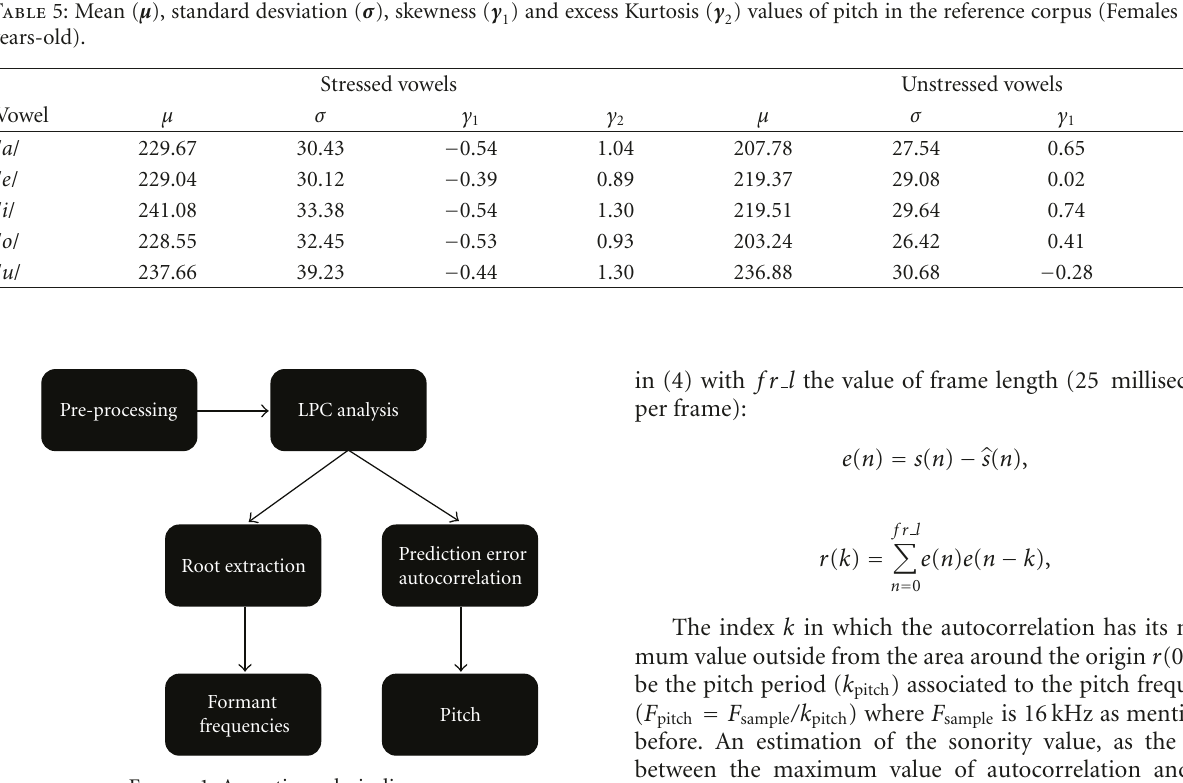
) and excess Kurtosis ( γ ) values of pitch in the reference corpus (Females 13-14 1 2